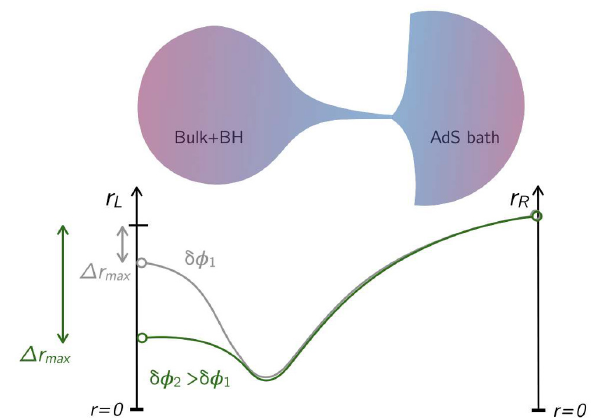
Figure 10 . The curve illustrates the cross-section at constant y of the minimal surface at a fixed value of the dilaton variation δφ = δφ 2 . The value of the dilaton variation determines a minimal anchoring r L in the bulk. Increasing the dilation variation lowers this critical anchoring point for which the surface can still reach the